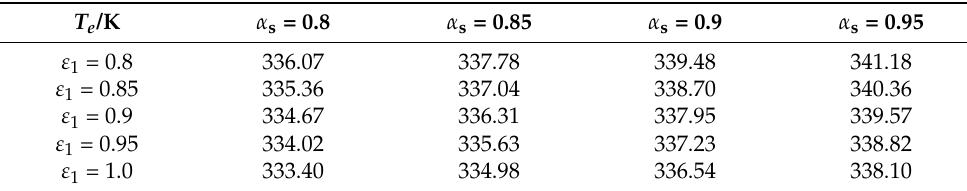
Table 10. Equilibrium temperature affected by common shortwave absorptivity and longwave radiation